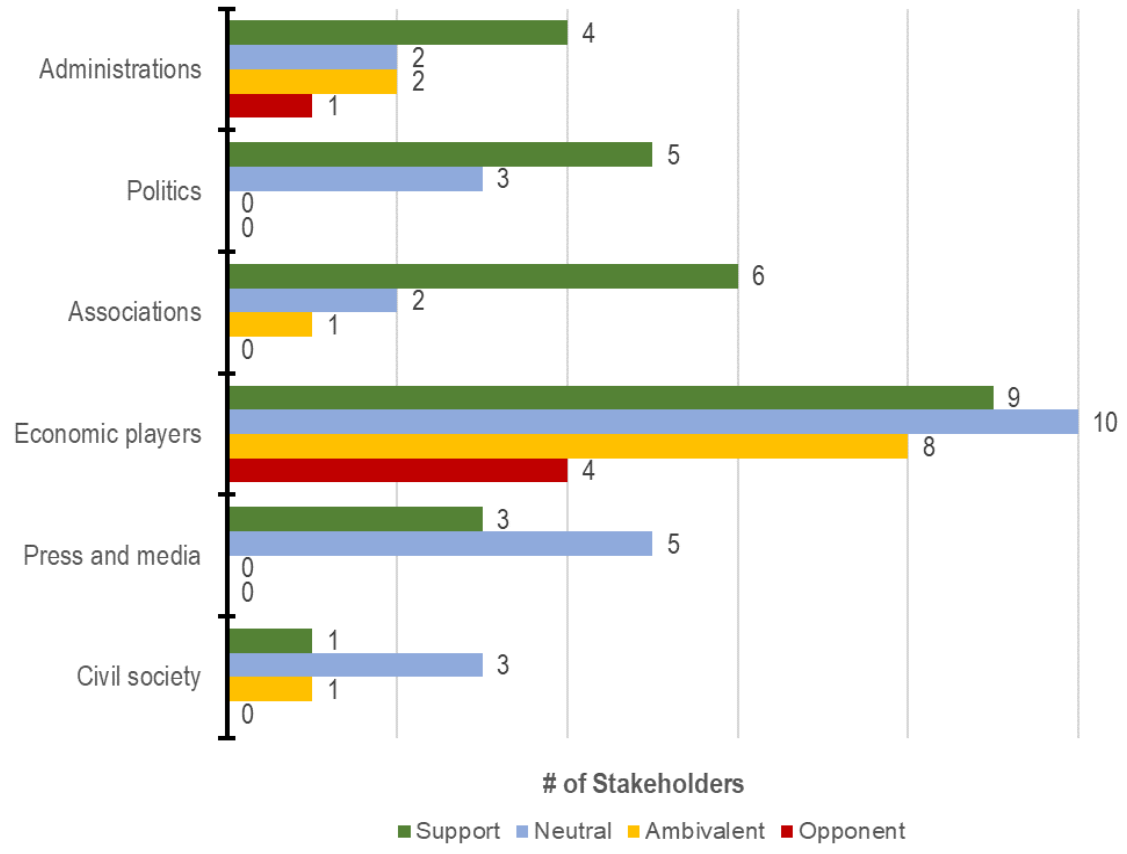
Figure 3. Attitude of stakeholders per category towards zero-emission heavy-duty trucks.